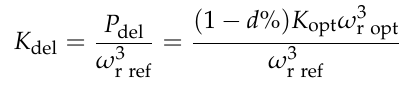
Table 1. Lookup table for deloading pitch